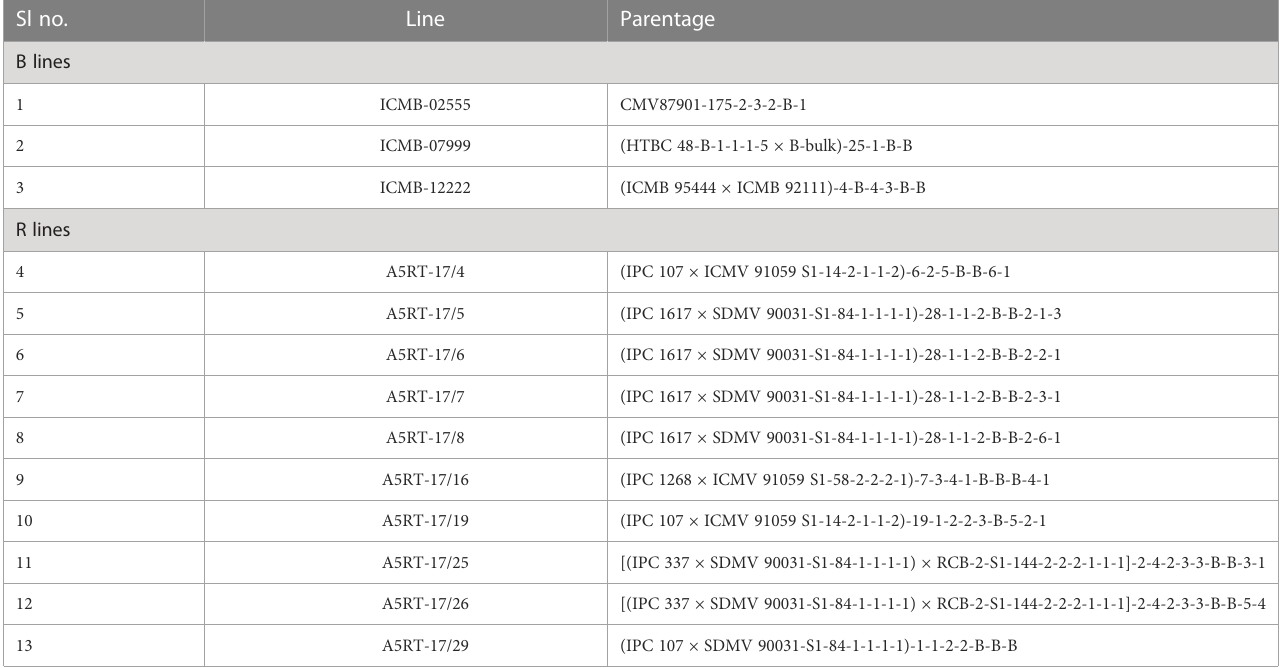
TABLE 1 Origin and parentage of B-lines (maintainer counterparts of A-lines) and restorer lines (R-lines). Sl